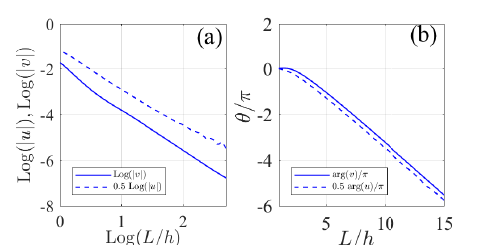
Figure 12: Dependence of the matrix elements v n and u n on the distance between disks L .